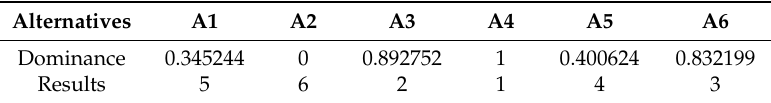
Table 8. Collective Sort Results of Alternative Items.